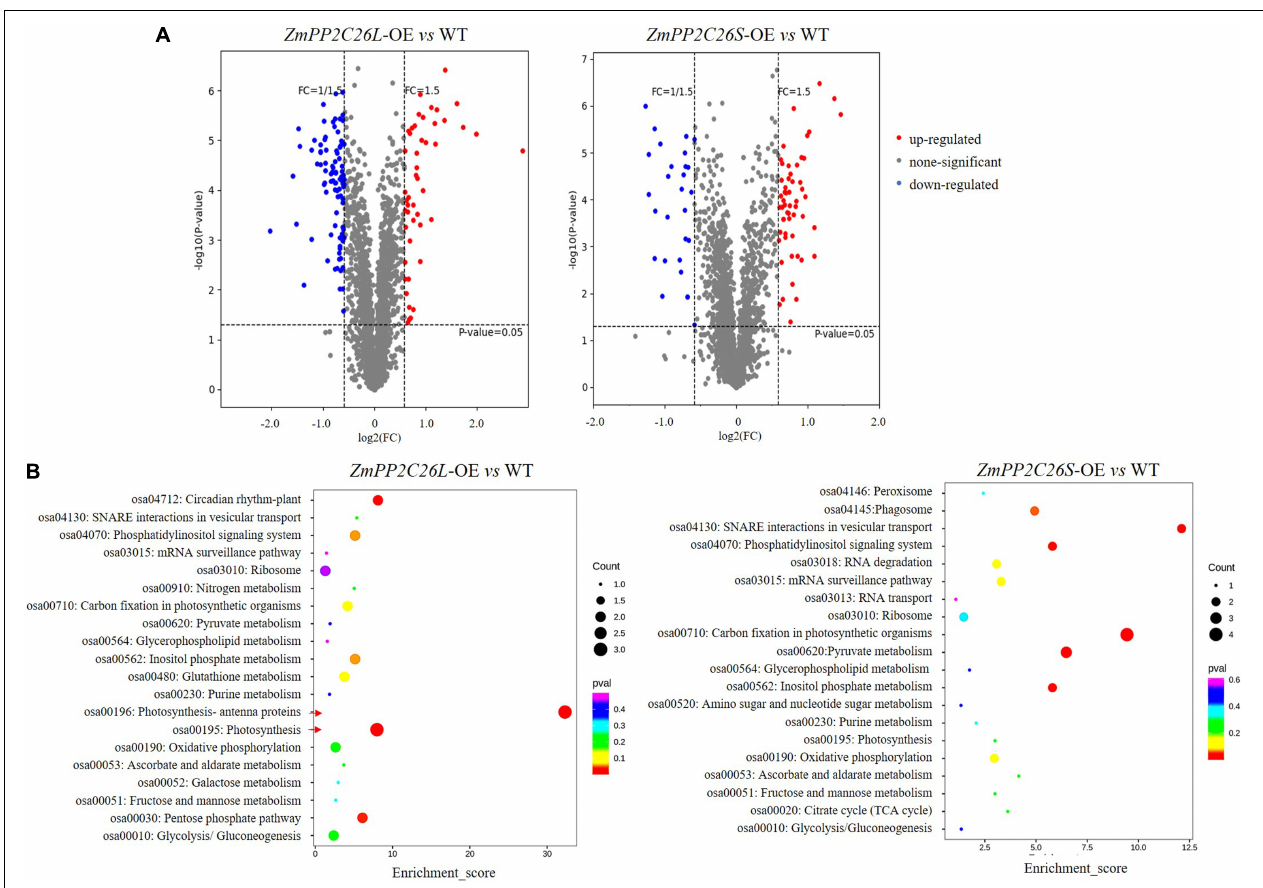
FIGURE 7 | Phosphoproteomics of transgenic rice identifies a set of ZmPP2C26 -affected phosphoproteins. (A) Phosphopeptide abundance for ZmPP2C26L - and ZmPP2C26S -overexpressing lines compared with WT. (B) The GO and KEGG analysis of ZmPP2C26L- and ZmPP2C26S -affected phosphorylation proteins.